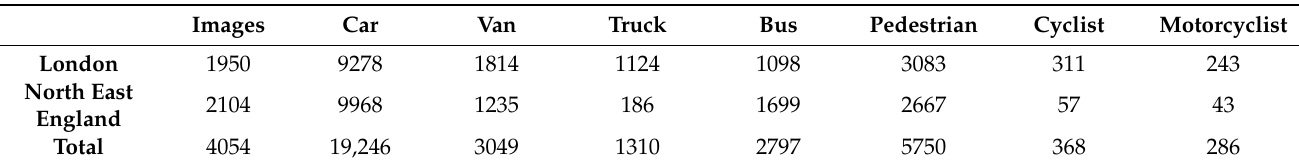
Table 3. Counts of labels generated from two collections of image data (London and North East England) by type of object